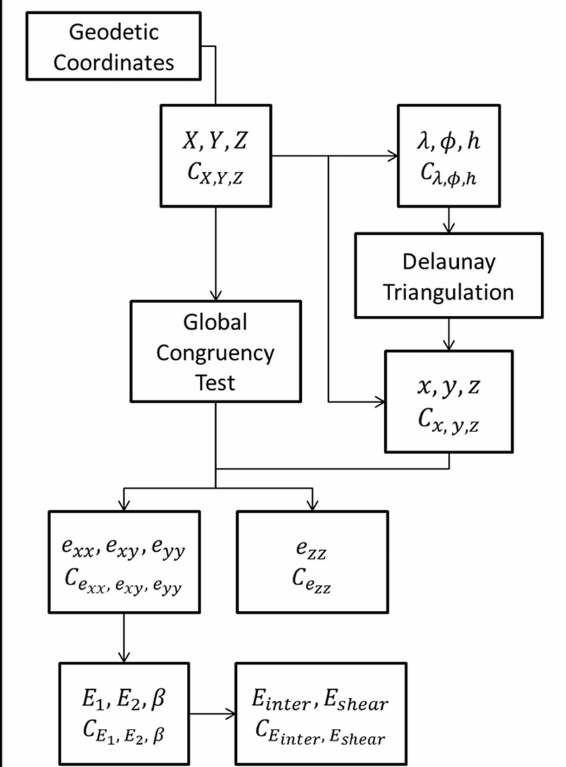
Figure 2. Flowchart of the routines used to calculate strains.